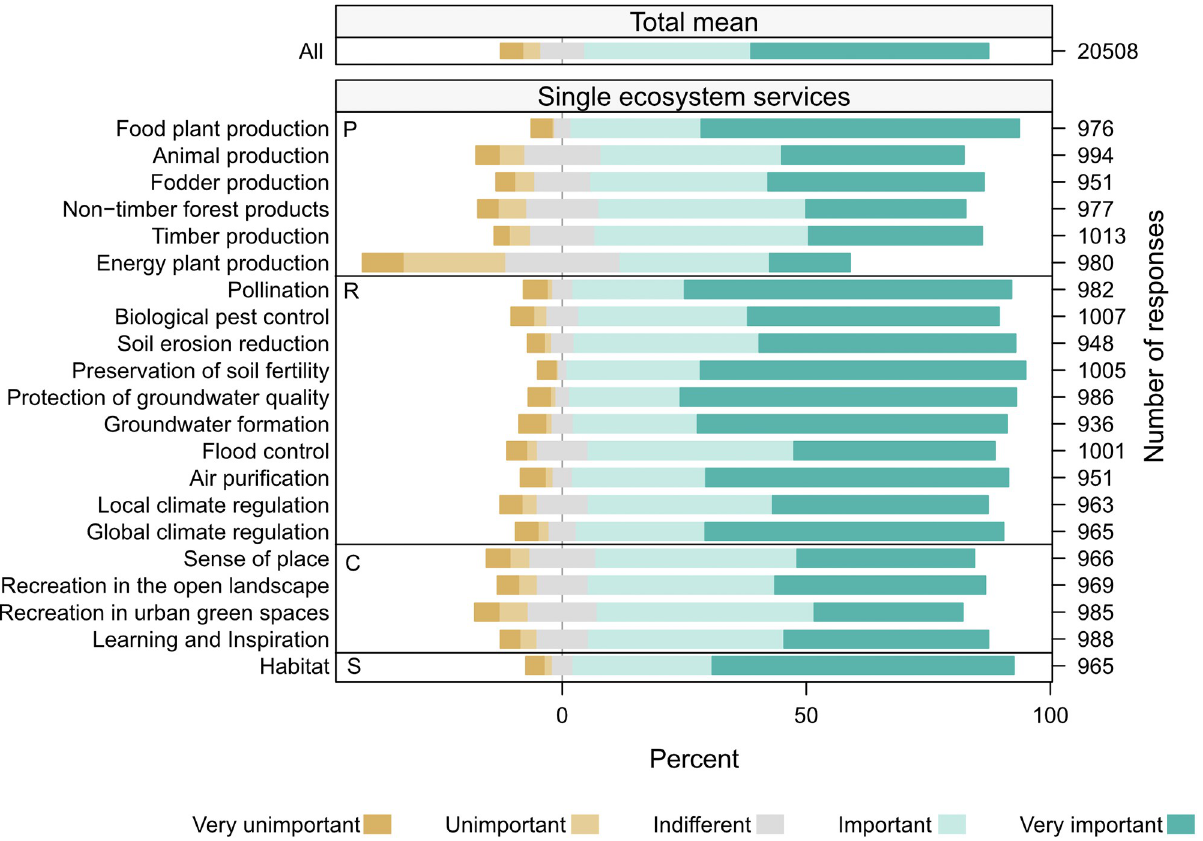
Fig 3. Overall perceived importance per ecosystem service ES (P: provisioning services, R: regulating services, C: cultural services and S: supporting services). The respective question was “How important are the following services of landscape and nature?” Segments in turquoise stand for the percentage share of answers in the important or very important category. Indifferent answers are split equally around zero percent. Segments in brown represent the percentage share of answers in the unimportant or very unimportant categories. Numbers on the right side of each row represent the number of responses for each respective ecosystem service. The high number of responses (i.e. 20508), is due to aggregated ES answers; each of the 3,018 respondents could give an answer for seven ES.